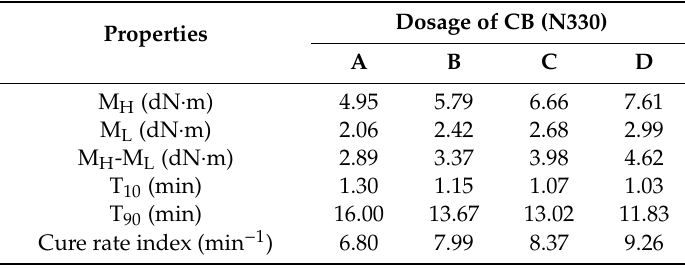
Table 2. E ff ect of carbon black (CB) dosage on cure characteristics of TPI / LDPE composites.